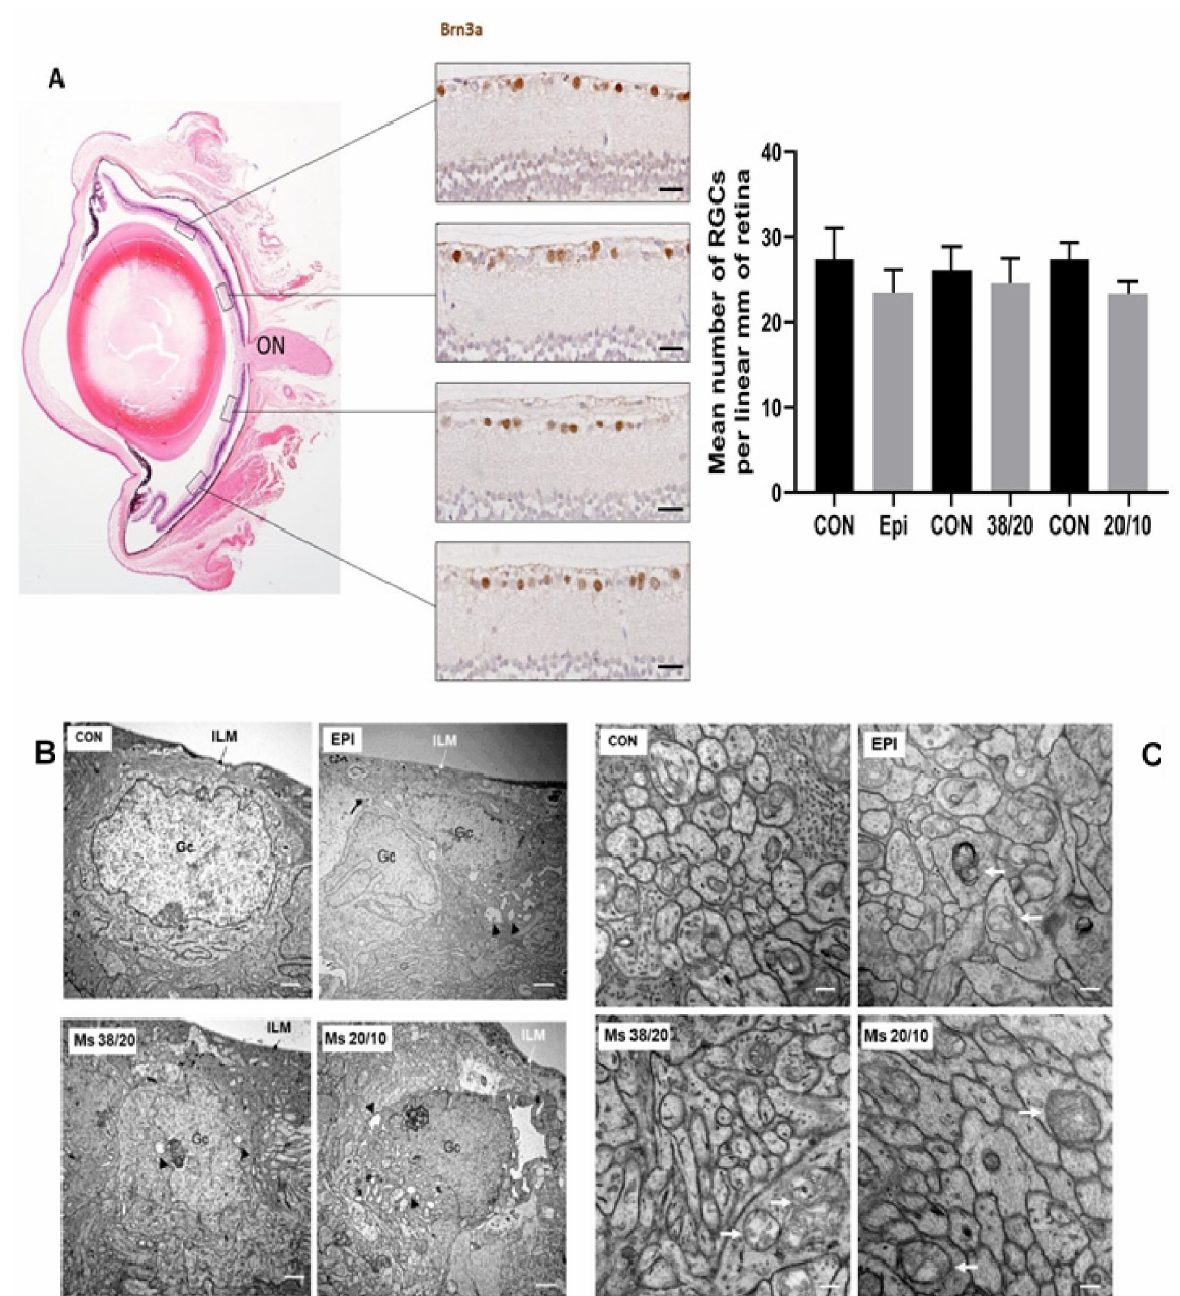
Figure 7. Neurodegeneration of ( A ) ganglion cell layer, ( B ) somas and ( C ) axons. (A) Ganglion cell analysis. Ganglion cells were counted in radial sections of the eye along 2 mm of a linear region of the retina. These corresponded to four areas, two on each side of the optic nerve (ON). Nuclei of ganglion cells were marked with anti-Brn3a. Right image: mean number of ganglion cells per linear mm of retina. Scale bars: 27.73 µ m. ( B ) Degeneration of ganglion cells in OHT models at 8 weeks. Nuclear and nucleolar ultrastructural alterations, including indentations of the nuclear membrane and cytoplasmic vacuolization were observed in all OHT models. Scale bars: 1.13 µ m. ( C ) Enlarged mitochondria (arrows) were observed in the axons of ganglion cells in all OHT models at 8 weeks. Scale bars: 0.29 µ m. Abbreviations: EPI: right eyes injected in the episcleral vein; Ms38/20: right eyes injected with 38–20 µ m microspheres; Ms20/10: right eyes injected with 20–10 µ m microspheres; RGC: ganglion cell; CON: right eye from a nontreated rat; GC: ganglion cell; ILM: internal limiting